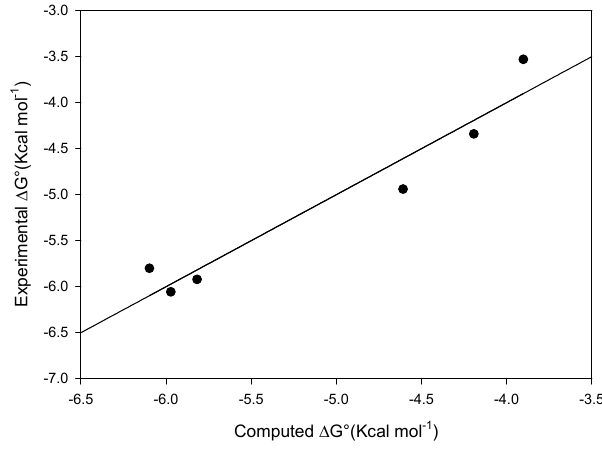
-4,0 -3,8 -3,6 -3,4 -3,2 -3,0 -2,8 -2,6 -2,4 -2,2 Computed Δ G°(Kcal mol -1 ) Figure 3. Computed vs Experimental Δ G° values of dataset R =0,9627, Rsqr=0,9269.